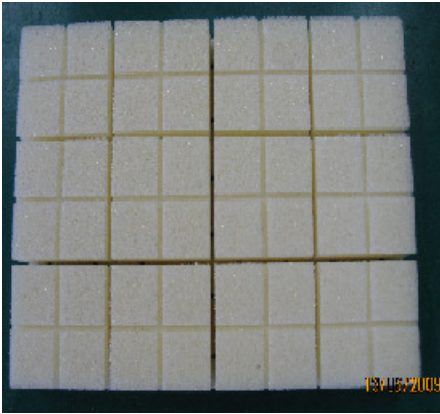
Figure 6. Physical model of foam sandwich